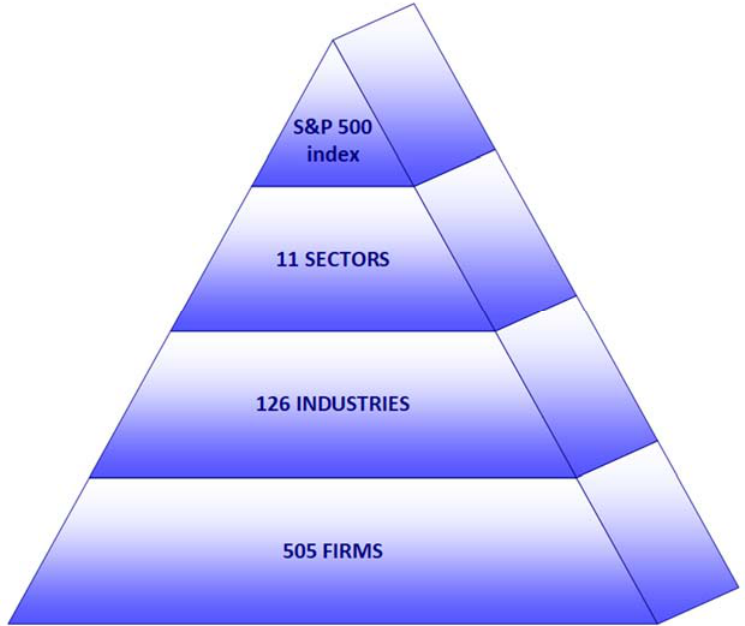
Figure 1. Overview of the S&P 500 index, sectors, and industries. Apart from geopolitical risk, other types of risk are also known to impact the stock return of firms. Examples of other risks include risk from the financial crises (such as recession (BenMim and BenSaïda 2019), banking crises (Miyajima and Yafeh 2007)), risk due to government policy and regulatory decisions (Grout and Zalewska 2006; Lamdin 2001; Jeon et al. 2020), risk due to natural disasters and climate/weather